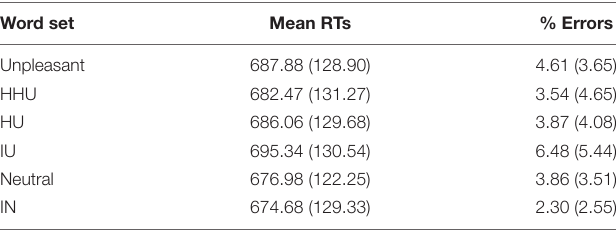
TABLE 2 | Mean RT (in ms), and percentage of error rates (% Errors) per set of words (standard deviations in